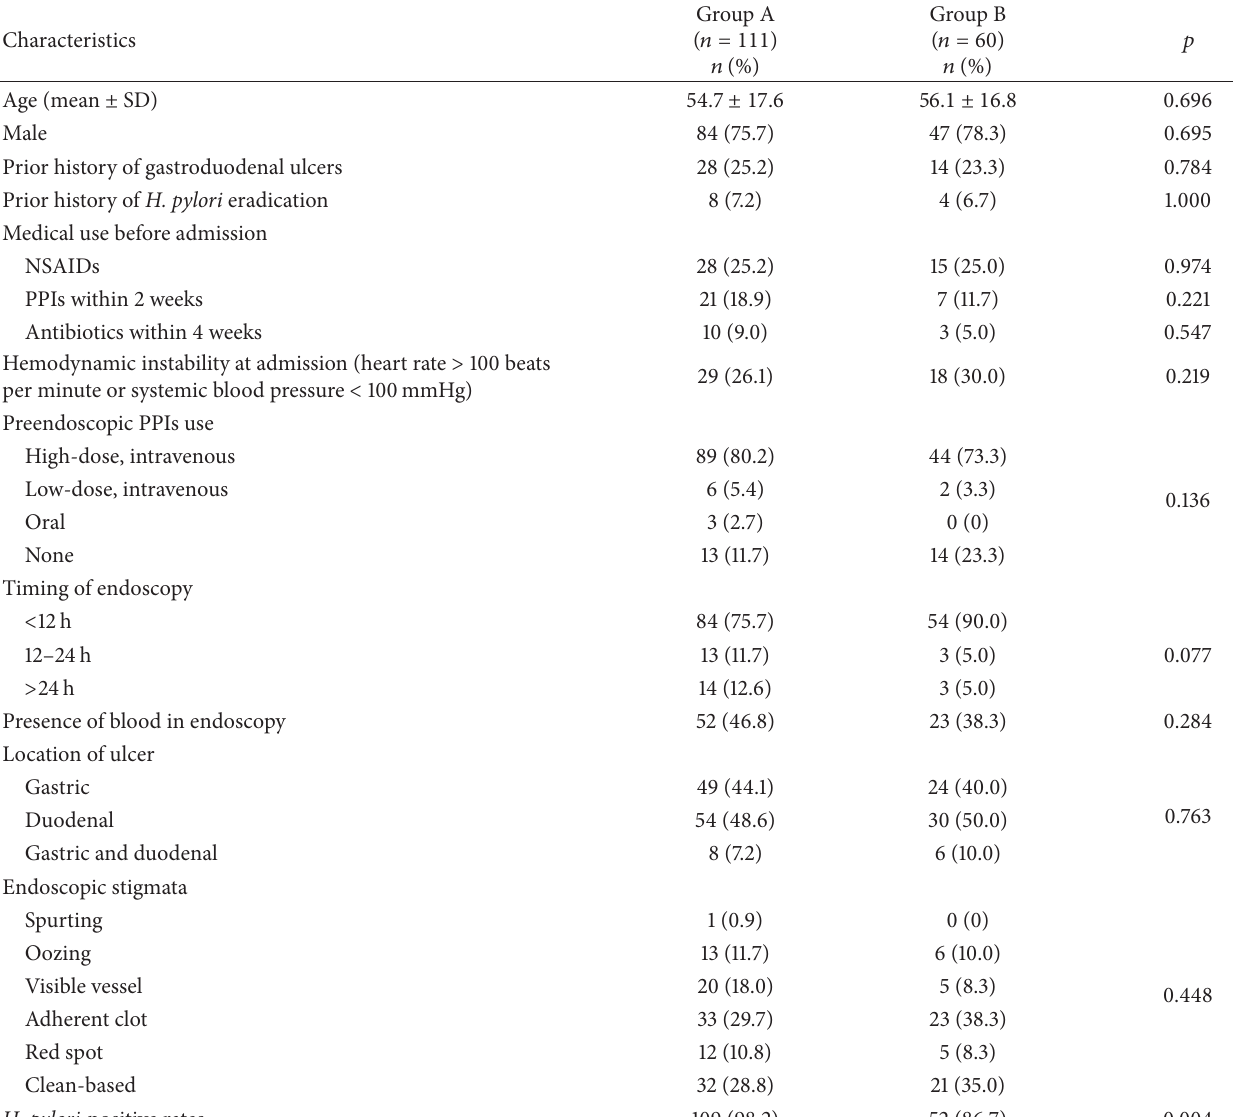
Table 3: The characteristics of patients in groups A and